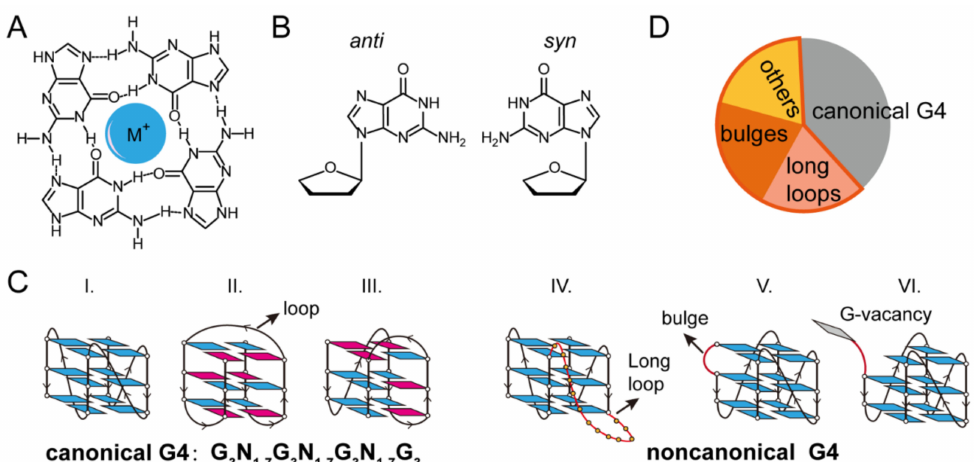
Figure 1. The structure of G-quadruplexes. ( A ) A G-quartet is associated with four guanines and stabilized by Hoogsteen hydrogen bonding and monovalent cations. ( B ) The anti and syn glycosidic bonds. ( C ) Schematic representation of canonical and noncanonical G4 topologies. Canonical G4s can be classified as parallel (four strands with the same orientation, I), antiparallel (four strands opposite to each other, II), and hybrid-stranded (one strand with the opposite orientation to the other three strands, III). Noncanonical G4s bear some special structural features, such as the G4 with a long loop (IV), G4 with a bulge (V), and G4 with a guanine vacancy (VI). ( D ) Populations of G4 structures in the human genome using high-throughput sequencing methods